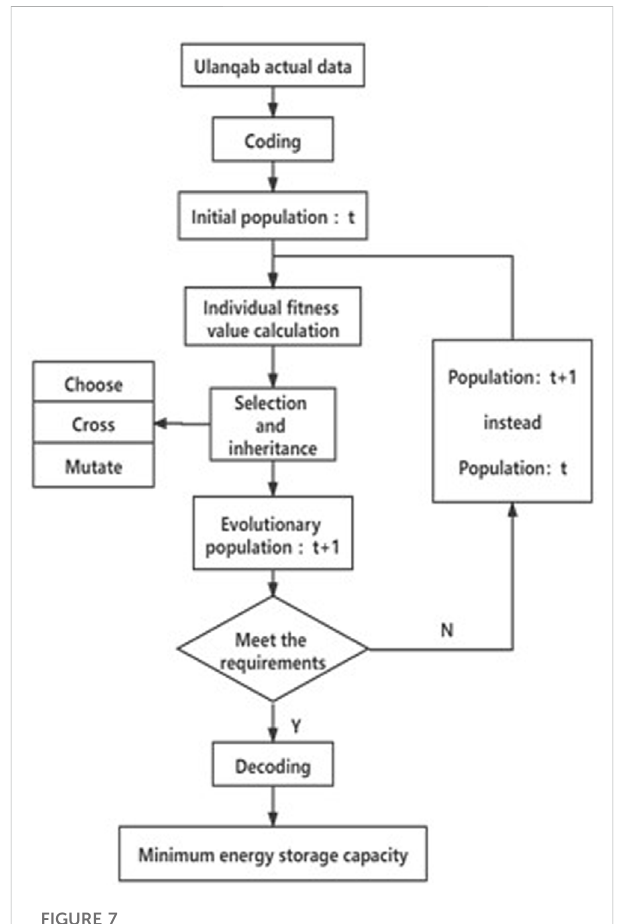
FIGURE 7 Genetic algorithm fl ow